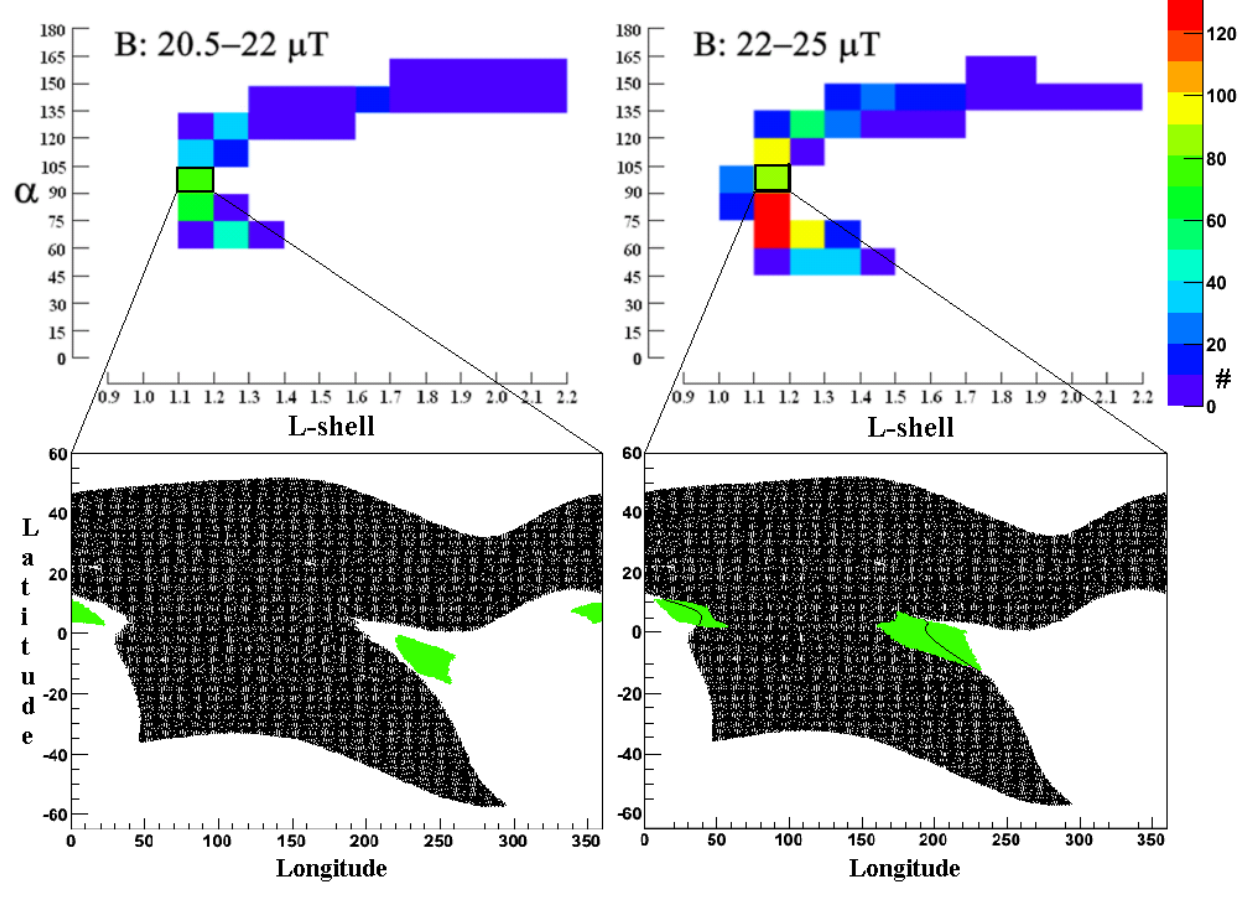
Figure 2. Top, the data distribution in L, α for two selected B-field values. Bottom, the data distribution in latitude and longitude, and for the two selected (L, α, B) bins (green), and the precipitating particle distribution (black).